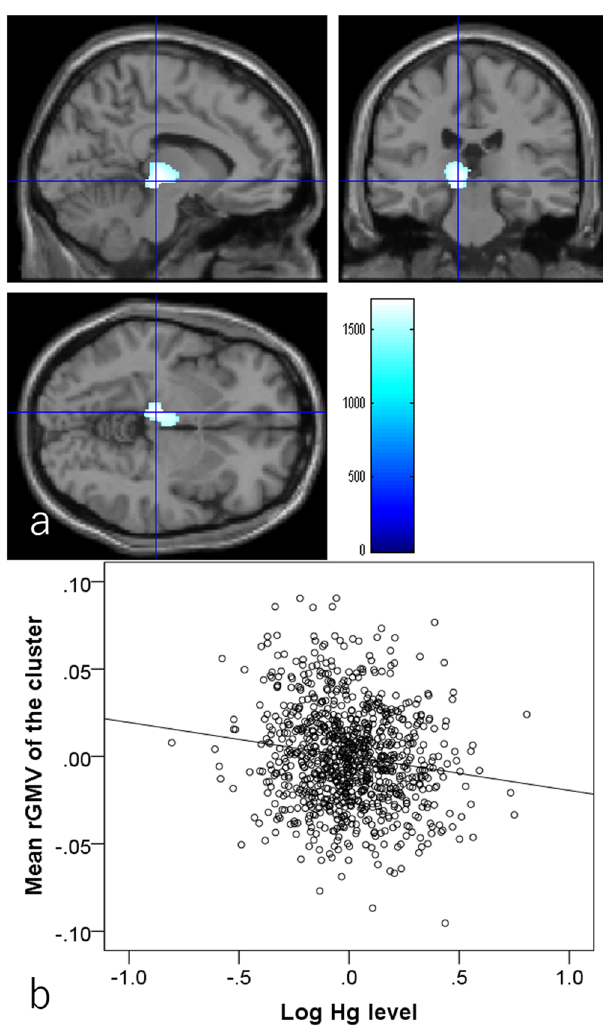
Fig. 2 Associations of hair mercury level with regional gray matter volume (rGMV)( N = 920). Greater hair mercury level was signi fi cantly associated with lower rGMV in the area of the left thalamus and left hippocampus. Colored bars indicate threshold-free cluster enhancement (TFCE) scores. TFCE score is unit-free and re fl ects both voxel ’ s height and the sum of the spatially contiguous voxels supporting it; therefore, it re fl ects both the strength and extent of effects. All results are overlaid on a “ single-subject T1 ” SPM8 image. a Regions with signi fi cant results. The results shown were obtained using a threshold P < 0.05, corrected for multiple comparisons based on 5000 permutations using the TFCE score. b A partial residual plot with the trend line depicting the associations between residuals of mean rGMV in the signi fi cant cluster and the residuals of the logarithms of hair mercury levels with other confounding factors controlled. cerebellar peduncle, pontine crossing tract, corticospinal tract, body and splenium of the corpus callosum, lemniscus, fornix and cingulum, internal and external capsule, anterior, posterior, and superior corona radiata, posterior thalamic radiation, sagittal stratum, stria terminalis, superior longitudinal fasciculus, superior fronto-occipital fasciculus, inferior fronto-occipital fasciculus, uncinate fasciculus, and tapetum (Fig. 3 and Table 2). Again, the effect sizes of these signi fi cant associations between hair mercury levels and mean values of signi fi cant clusters were generally weak, and the absolute values of partial correlation coef fi cients all <0.140.